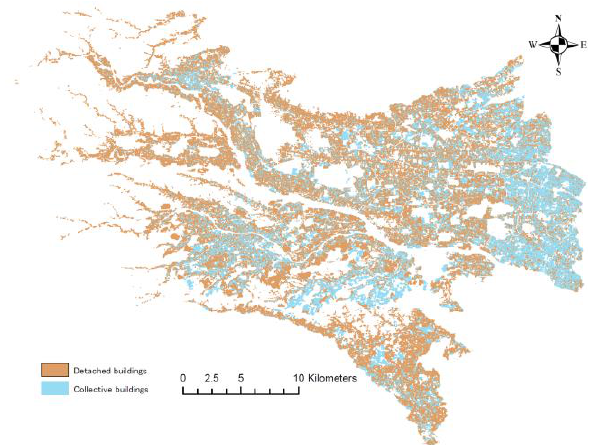
Figure 3. Extraction on two types of residential buildings in Tokyo (raster map at a resolution of 50 × 50 m):